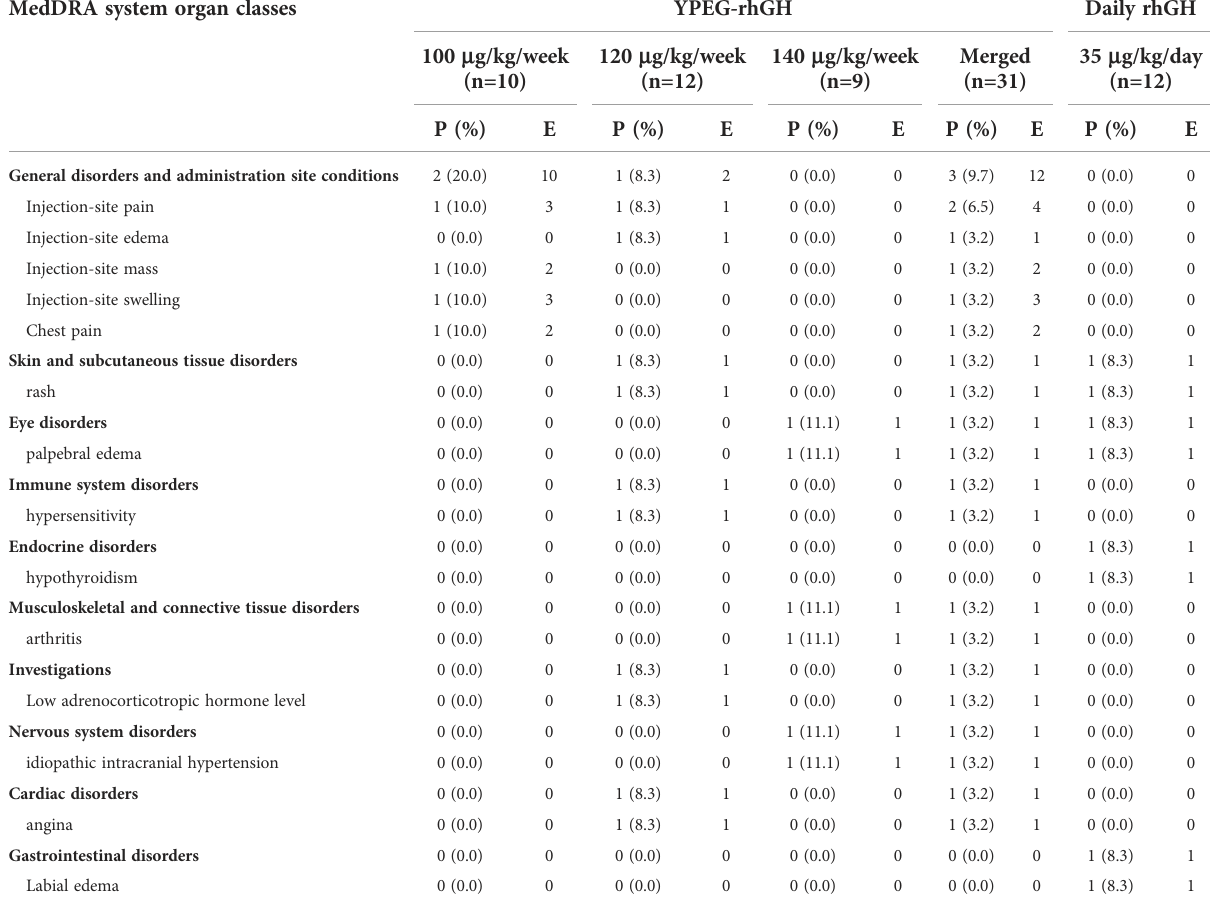
TABLE 7 Related adverse events in safety analysis set. MedDRA system organ